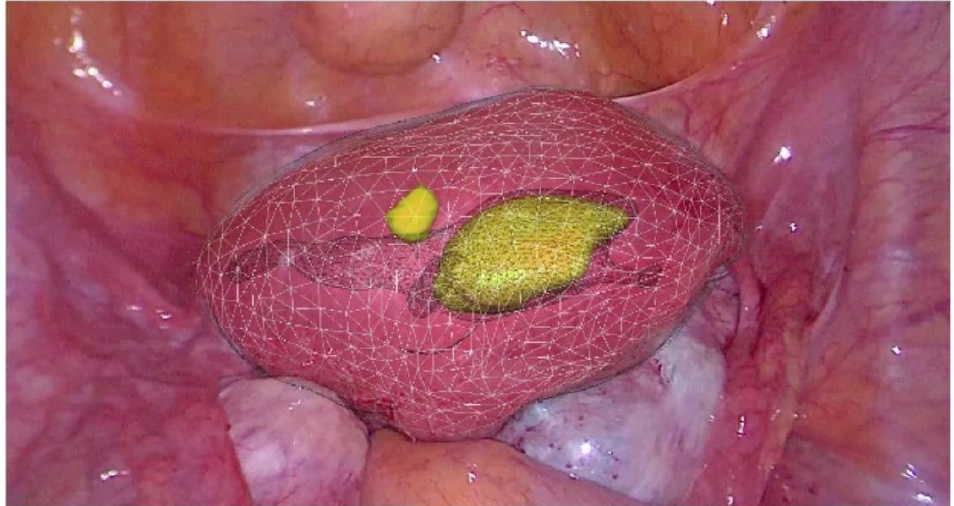
Figure 7. Real-time augmented reality (AR) for gynecology. Uterus is mobile and deformable (white) and intra-uterine tumors (yellow) (EnCoV, SurgAR, Clermont-Ferrand, France).